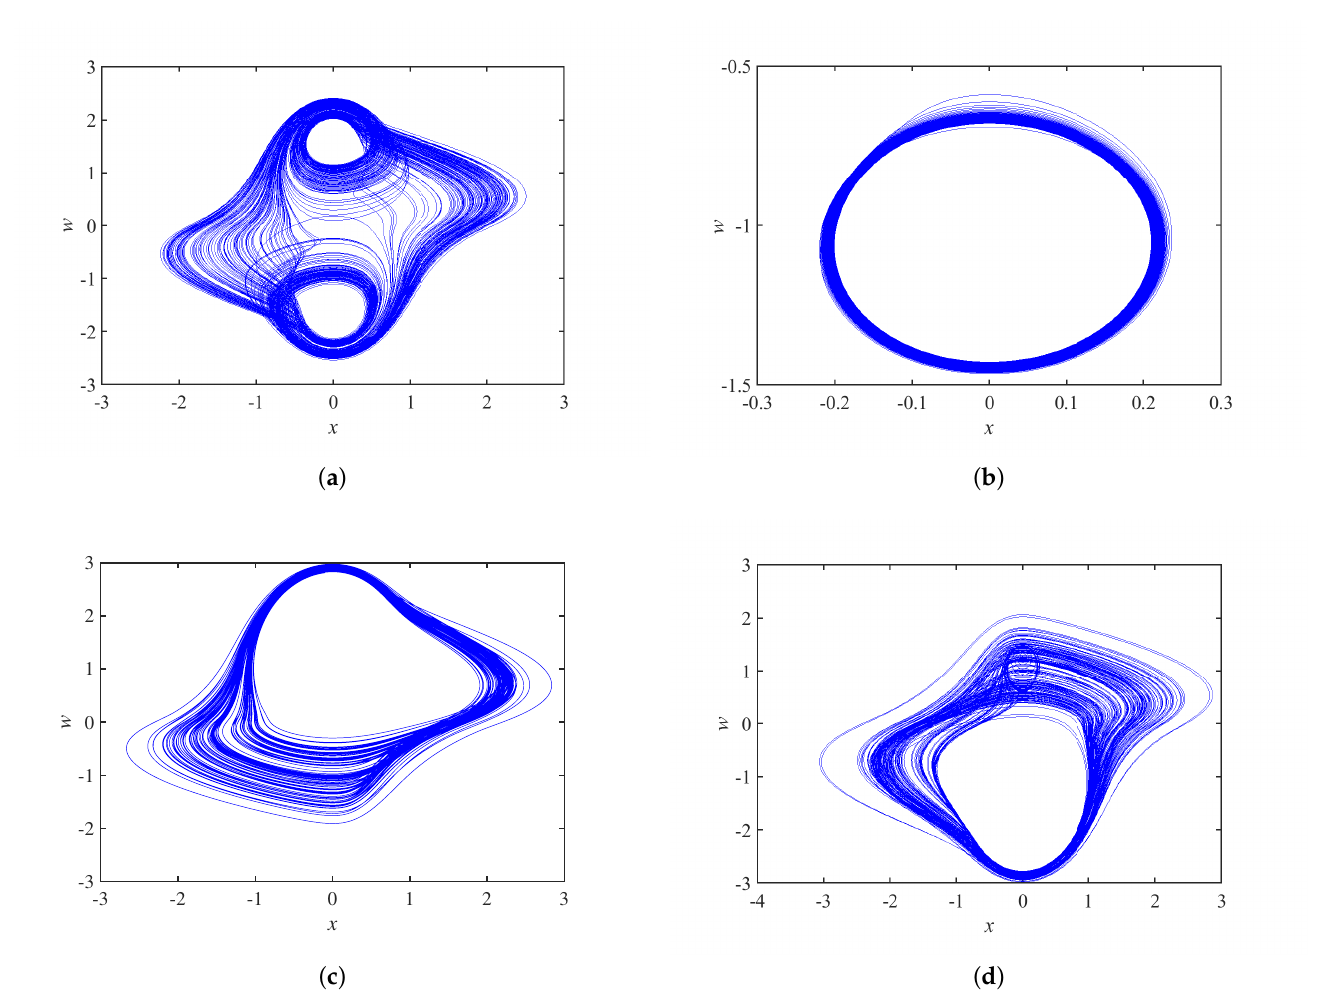
Figure 17. Phase portraits of initial state ϕ ( 0 ) at different values on plane x − w : ( a ) ϕ ( 0 ) = − 1.77;